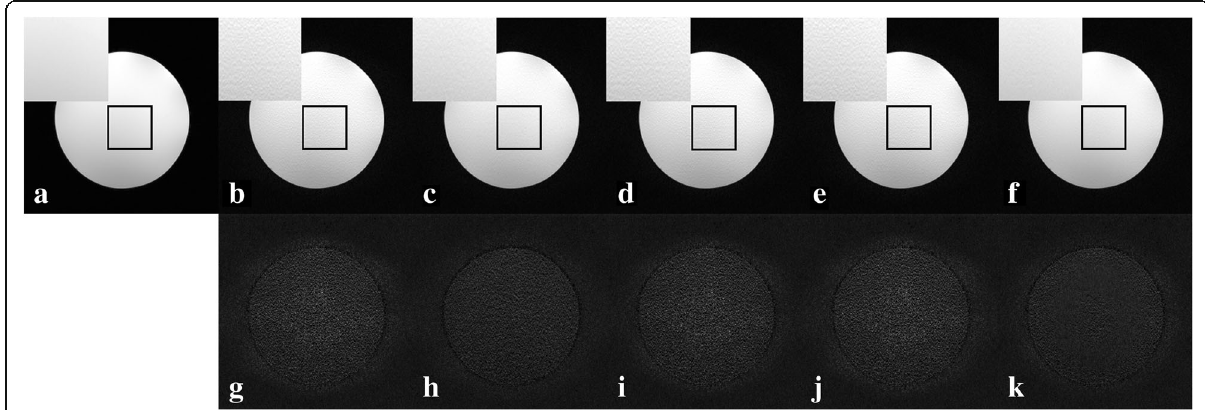
Fig. 2 Reconstructed images with ROI and difference maps of an eight-channel phantom data. The acquisition is accelerated with a net reduction factor of 2.29. a Reference image with SoS reconstruction. b GRAPPA reconstruction with 64 ACS lines and 4 outer reduction factor. c GRAPPA reconstruction with 40 ACS lines and 3 outer reduction factor. d Reconstruction using Tikhonov regularization. e Reconstruction using IRLS method. f Reconstruction using AV-GRAPPA. g – k Difference maps of b – f , respectively. AV-GRAPPA is able to reconstruct the original reference image good. Other methods lose some fine structures and result in noise and aliasing